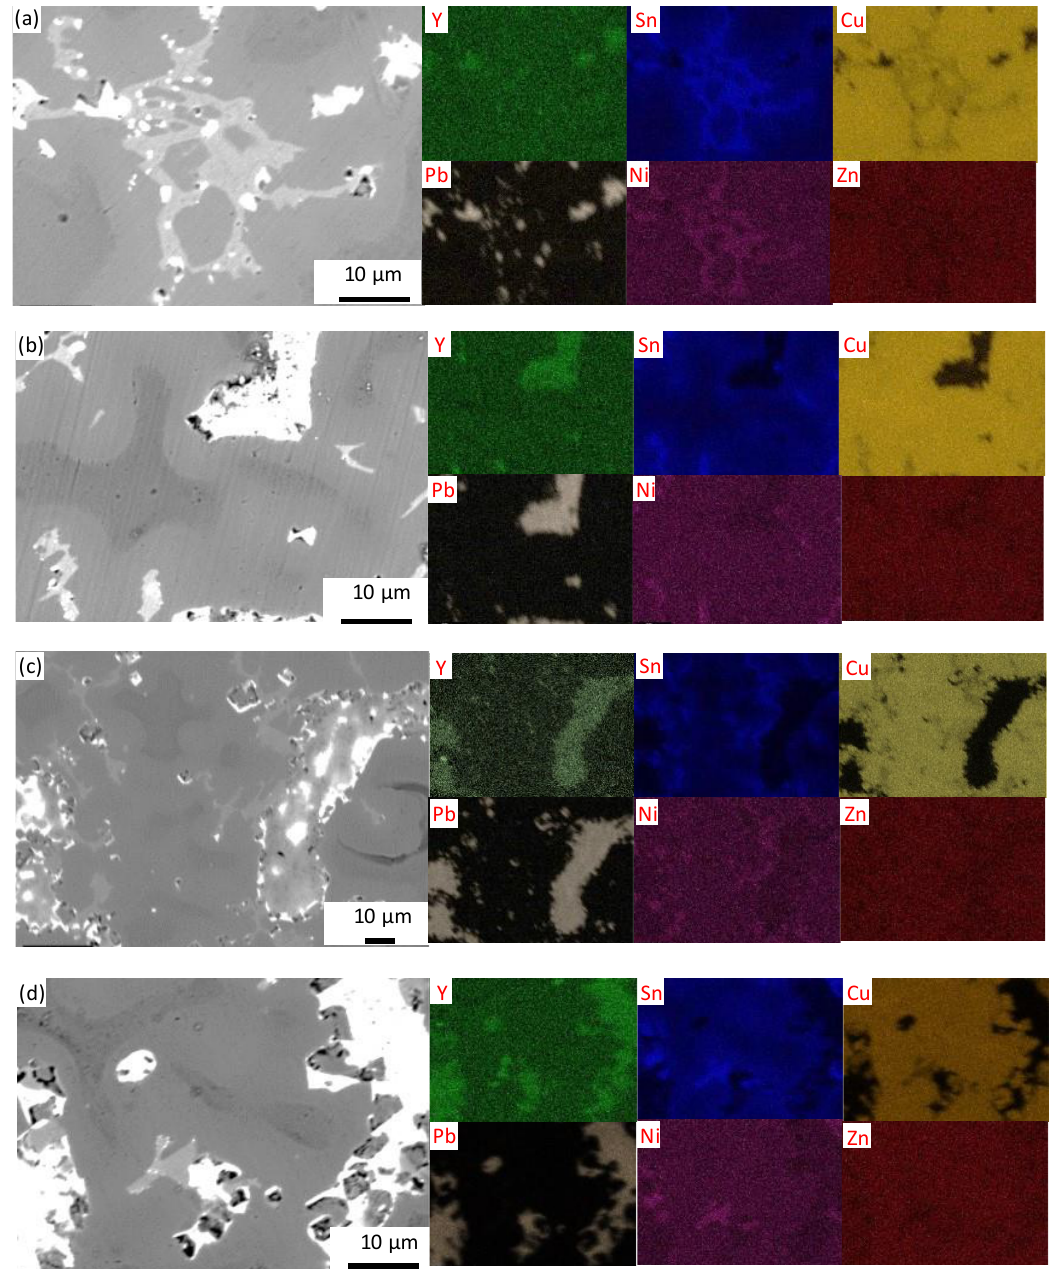
Figure 7. SEM micrograph (BSE mode) and EDS mapping of ( a ) ZCuSn10Pb10 + 0.05% Y, ( b ) ZCuSn10Pb10 + 0.1% Y, ( c ) ZCuSn10Pb10 + 0.15% Y and ( d ) ZCuSn10Pb10 + 0.2% Table 1. EDS results of the point in Figure 7c (wt.%).